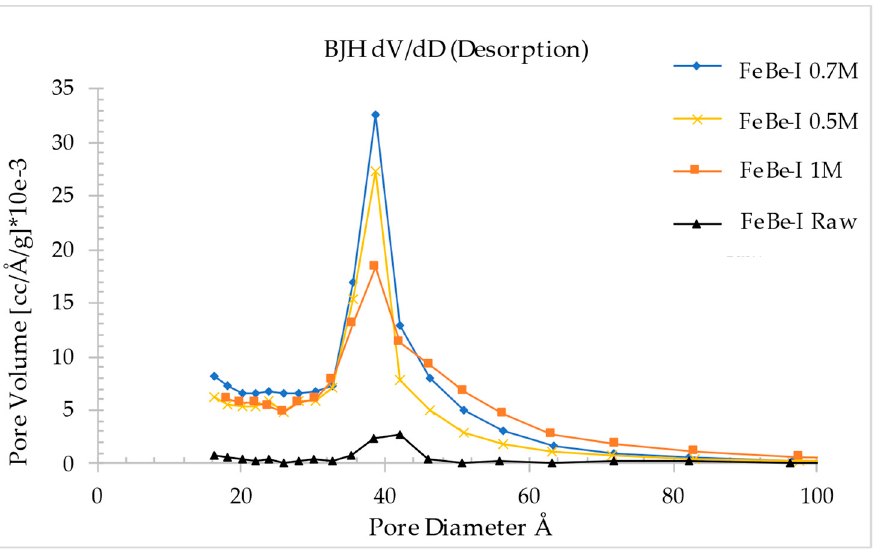
Figure 9. Pore size distribution of FeBe-I (80 °C; acid concentrations of 0.5 M, 0.7 M and 1 M; 2% of pulp density).